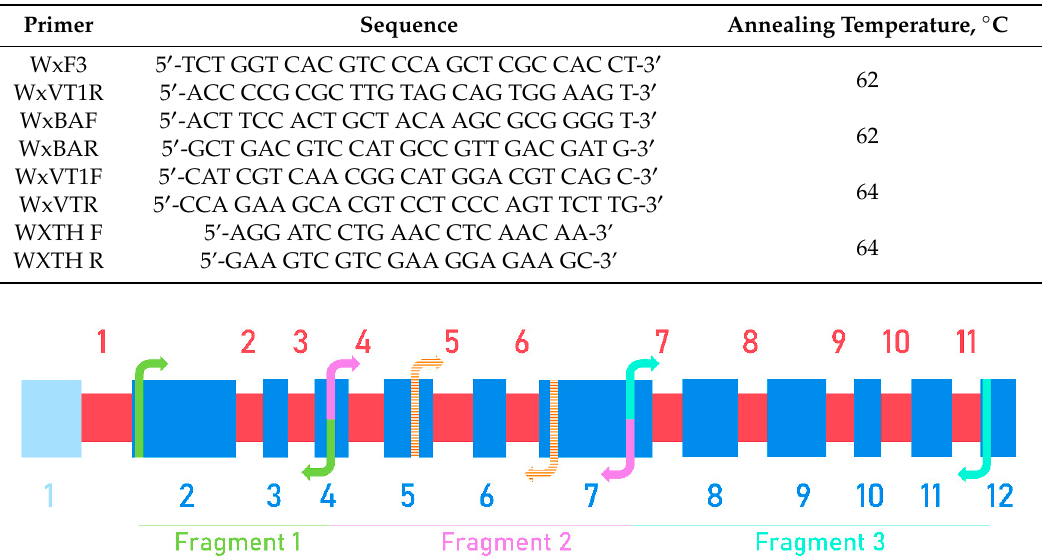
Figure 1. The schematic structure of the Wx gene of Triticeae . Blue boxes and numbers show exons, red boxes and numbers show introns. Scheme of the Wx gene is presented in accordance with [38], exon 1 (pale blue) is in the untranslated region. Fully colored arrows show primers taken from [74] for cloning Wx genes of the studied wild grasses: WxF3 / WxVT1R, green arrows; WxBAF / WxVT1F, violet arrows; WxVT1F / WxVTR, turquoise arrows. The respective fragments of amplification for cloning are shown. Peach striped patterned arrows show the WXTH F / WXTH R primers developed in the current study for the identification of Wx genes-orthologs of the studied wild grasses in the wheat background.